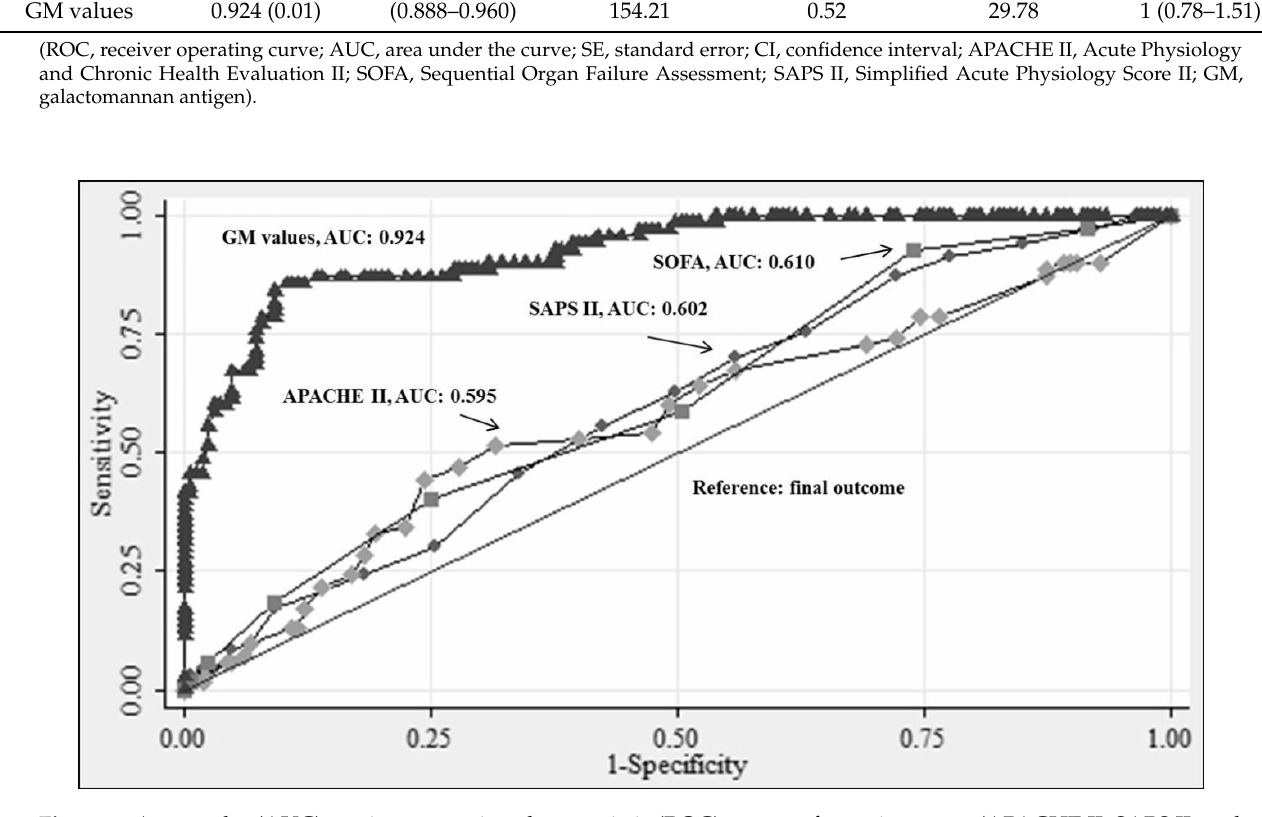
Physiology Score II; GM, galactomannan antigen).